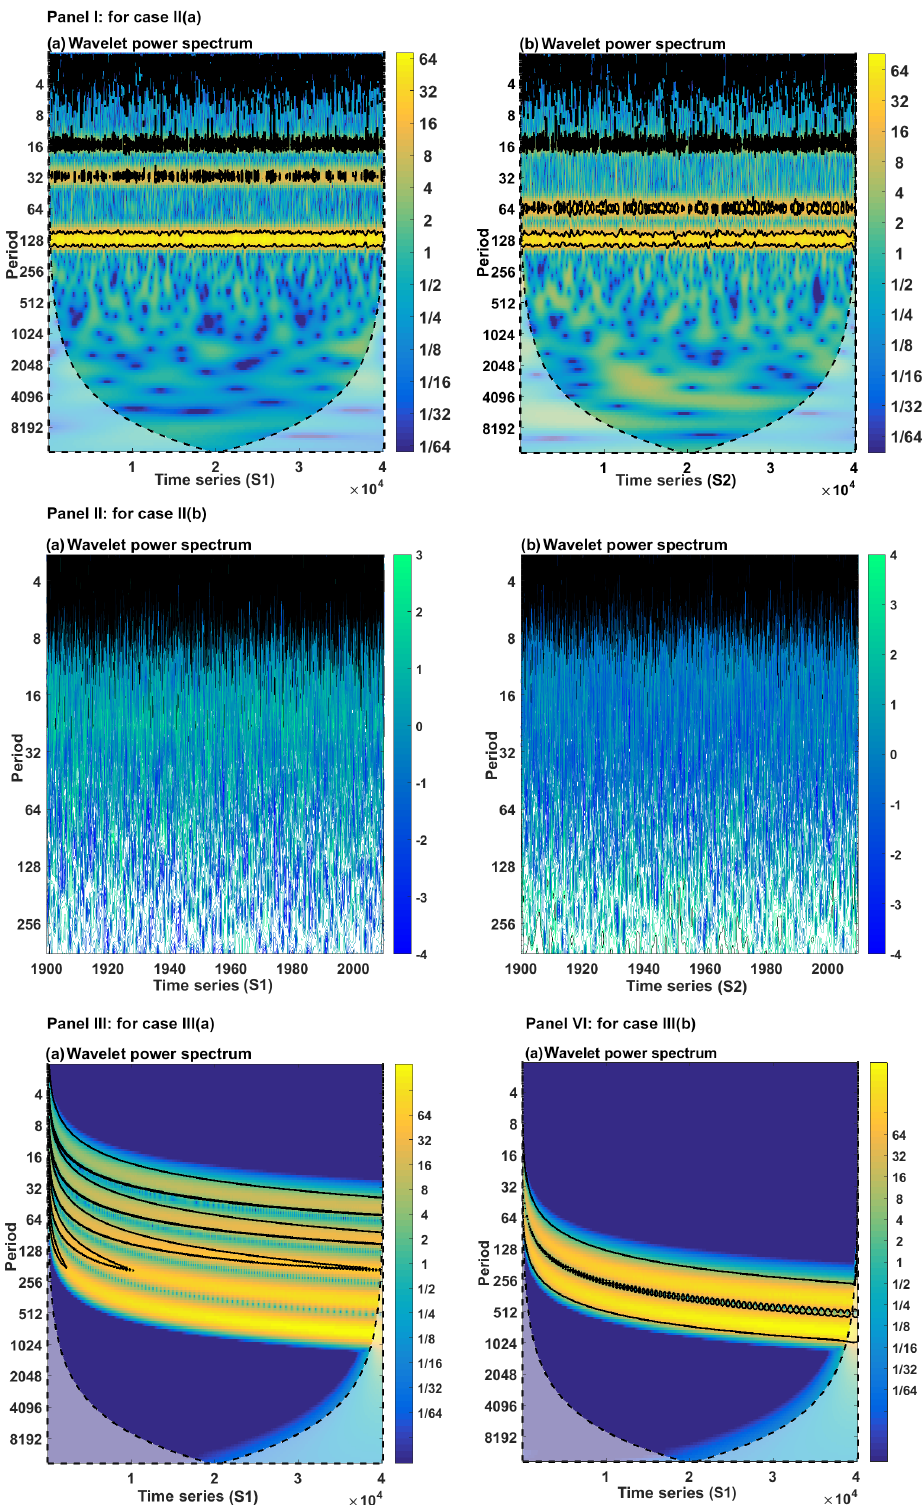
Figure 4. Wavelet power spectra (WPS) of the test signals (Table 1). Panel I: original signal S1 (left) and S2 (right), respectively, for case II(a); Panel II: original signal S1 (left) and S2 (right), respectively, for case II(b); Panel III: original signal S1 for case III(a); Panel IV: original signal S1 for case III(b). In all the panels, the y-axis represents the corresponding Fourier period = 2 λ